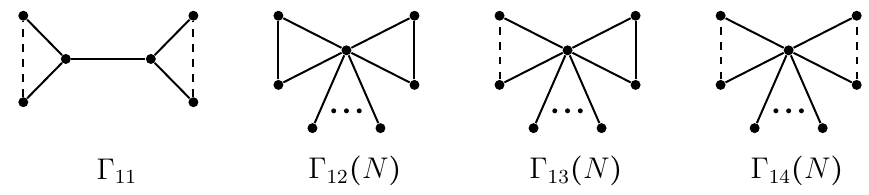
Fig. 3: Bicyclic graphs Γ with θ ( Γ ) ⩽ 3 and circumference c = 3 . Dashed lines represent negative edges.